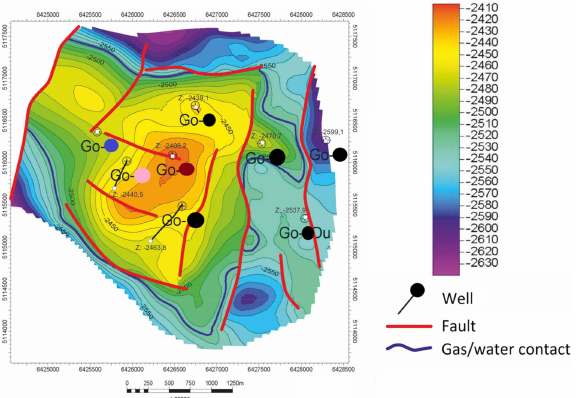
Figure 1. Contour map of the formation top depths with the gas/water contact. The model was spatially populated with porosity data (Figure 2) by the kriging method.